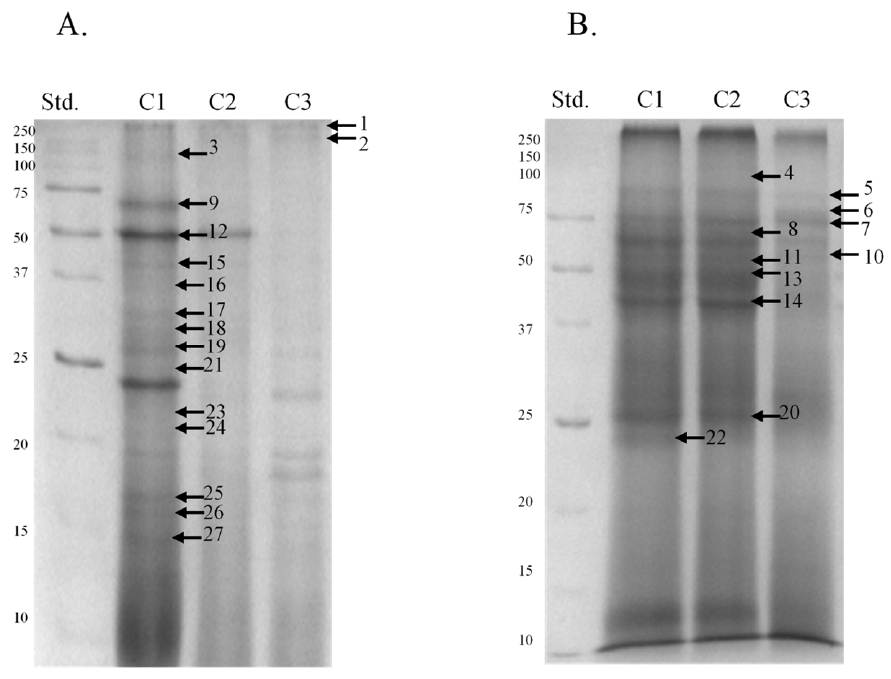
Figure 3. SDS ‐ PAGE profile of sperm proteins obtained during out of the breeding season. C1— caput, C2—corpus, C3—cauda. Std.—molecular weight standards.